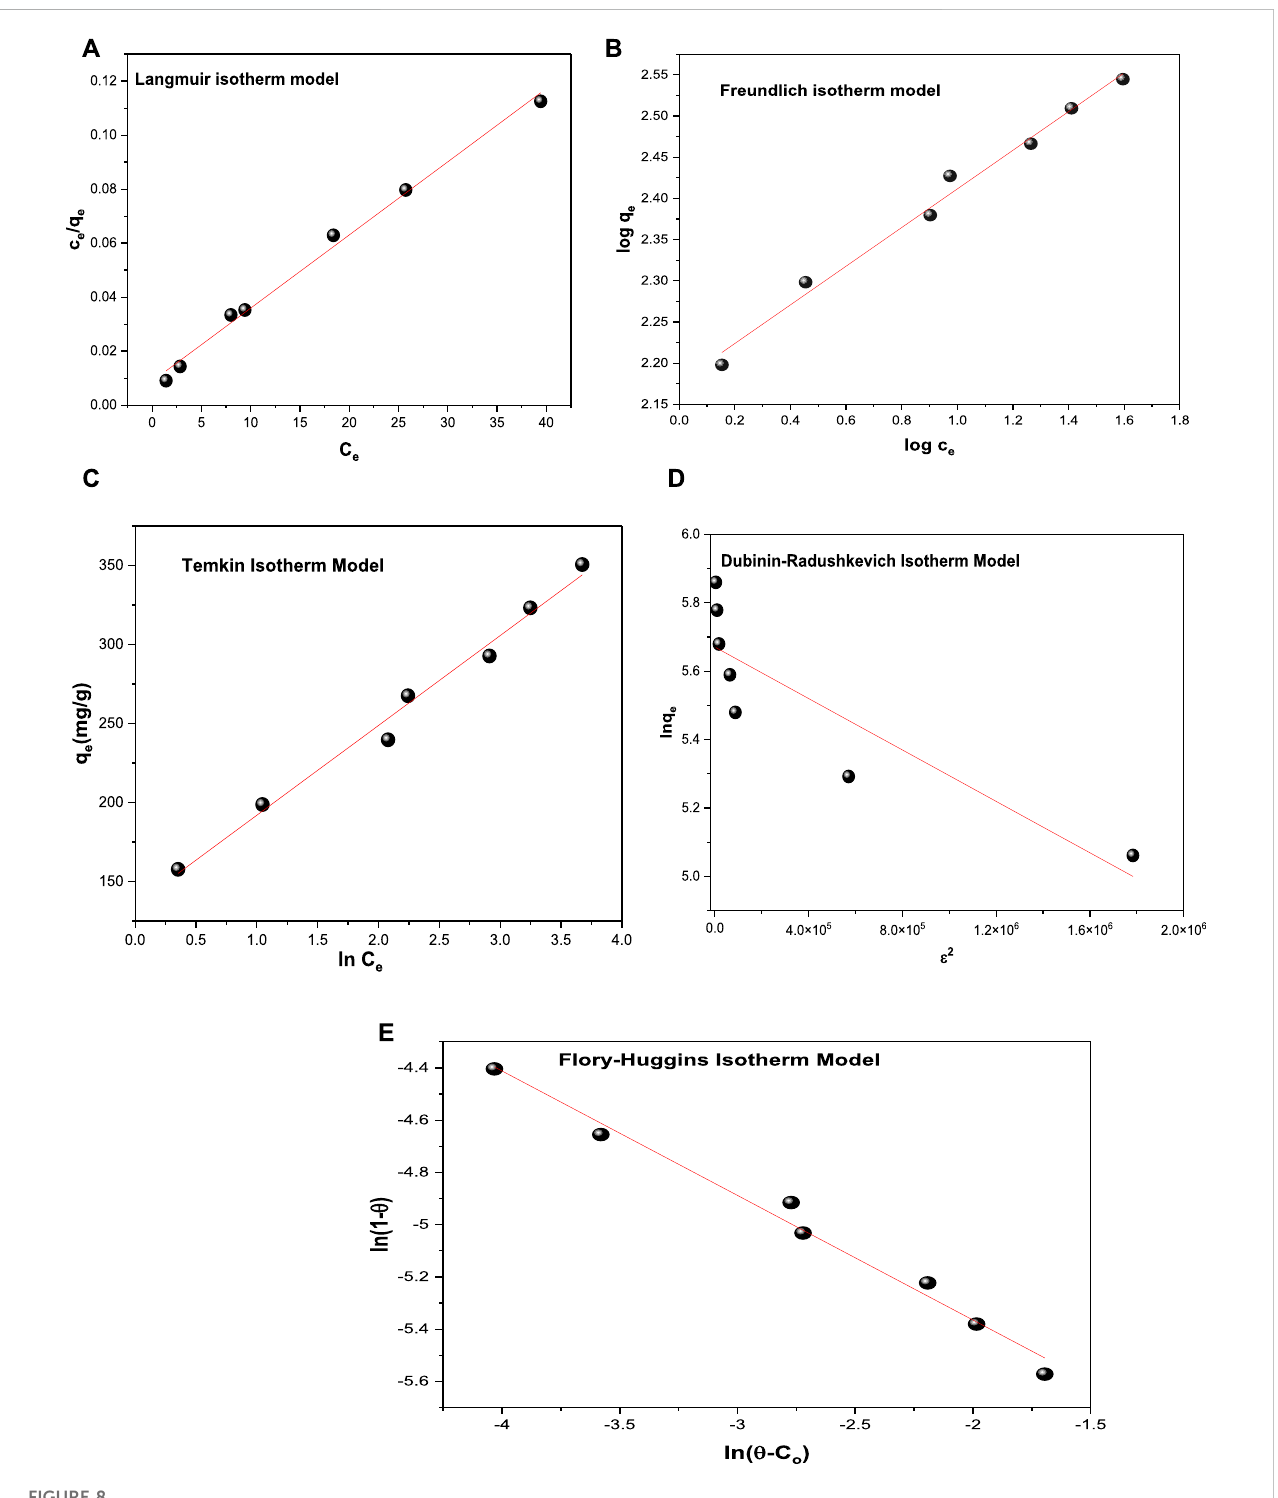
adsorbent CM- β CD:nChi:Glu. The linear equations of the applied isotherm models are given in Supplementary Table S2, expressed as Supplementary Equations S5 –